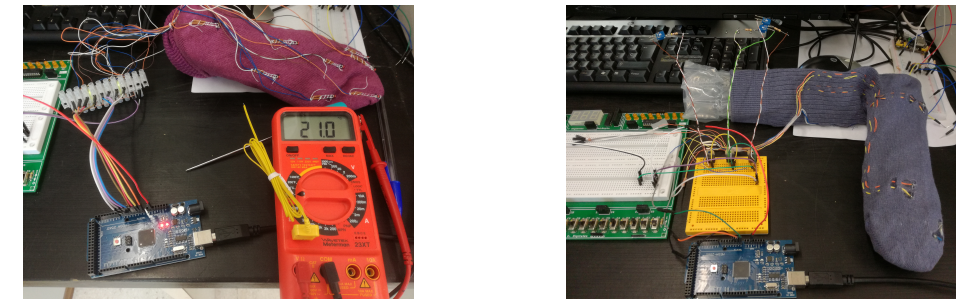
Figure 4. Prototype developed to collect temperature data: ( a ) sock developed with eight NTC sensors located on the sole of the foot, and a polymer with a thermocouple; ( b ) we set with PT100 sensors and the auxiliary circuitry to measure the PT100 with four